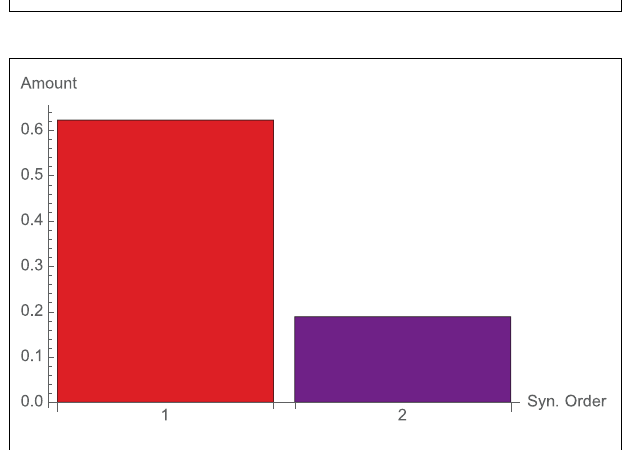
FIGURE 8 | Synergies of different orders for the AND (and OR) function, Example 3.5